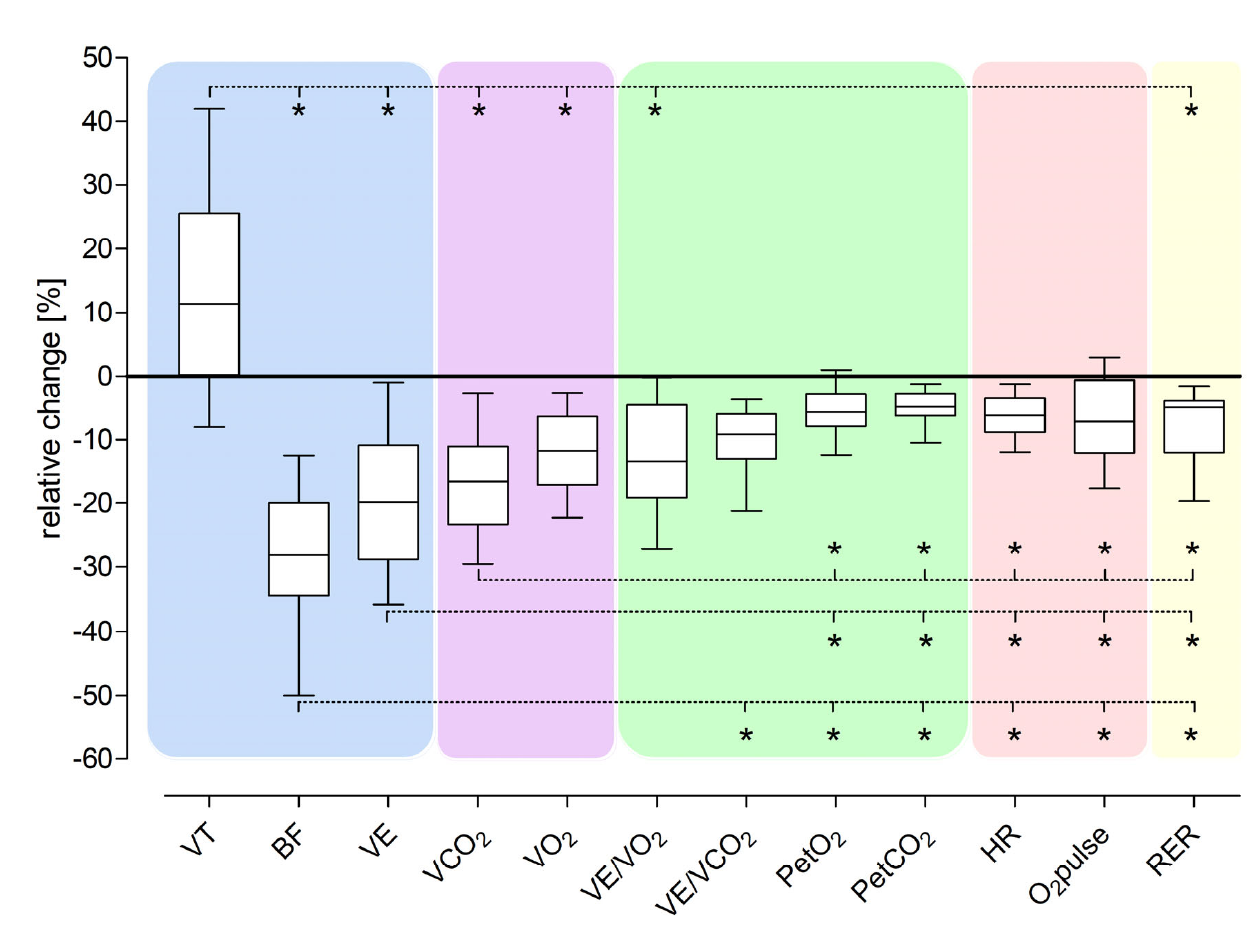
Figure 2. Comparison of relative changes of CPET parameters from CPET2 (run with vAT with +12 kg